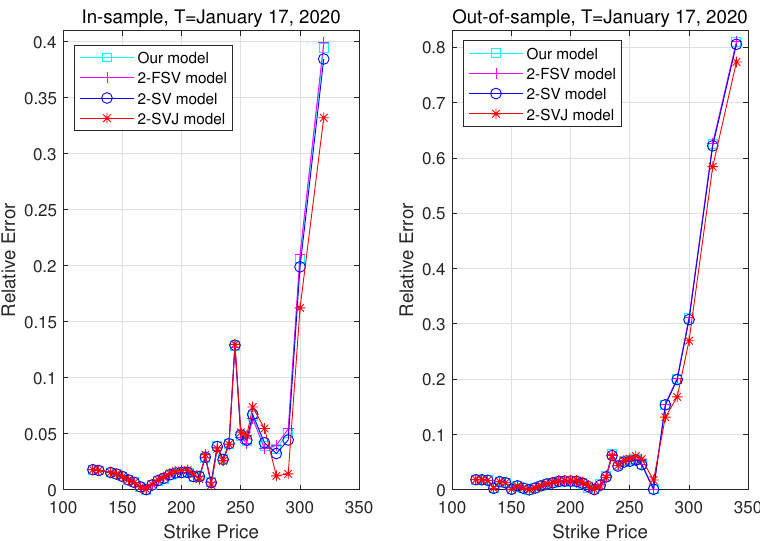
Figure 10. The comparison of predicted prices of four model specifications and market prices on 9 May 2019, with maturity T = 17 January